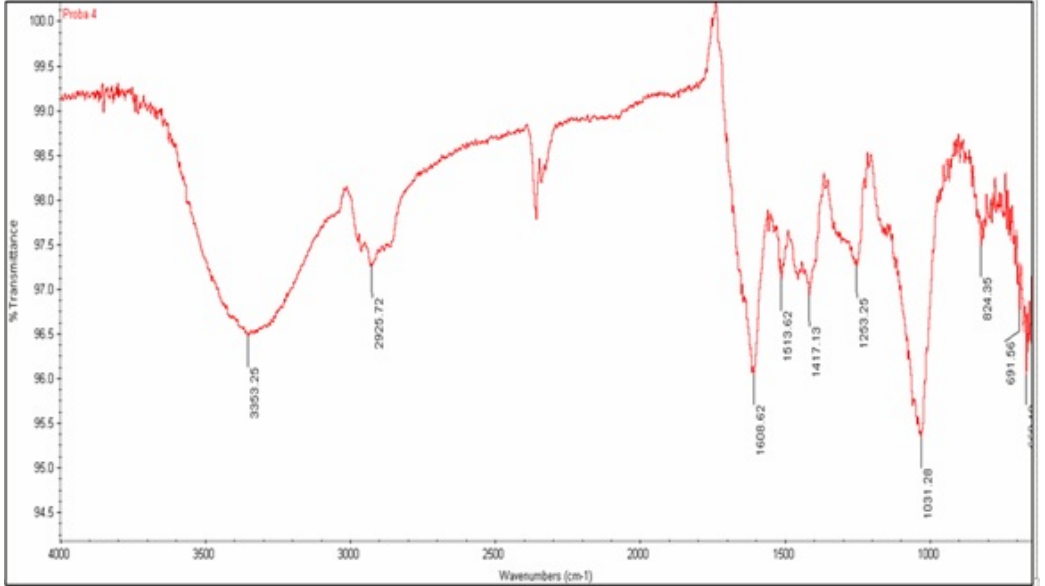
Figure 1. The FT-IR spectrum of Cystoseira barbata powder. The signal at 3353.25 cm − 1 corresponds to the -OH group ( υ OH = 3200–3600 cm − 1 ), but in the same broad band the presence of the amine group is also detected ( υ NH = 3300–3500 cm − 1 ). The width of the 3353.25 cm − 1 band denotes the association of molecules with hydrogen bonds. The presence of -NH bending at 1608.62 cm − 1 also confirms the presence of amine groups. A band of medium intensity at 2925.72 cm − 1 shows the valence vibration of C-H bonds in alkane chains ( υ CH = 2850–2960 cm − 1 ); there is a fairly broad band which may indicate the presence of a carboxylic acid with molecules strongly associated with hy- droxyl groups with hydrogen bonds ( υ - OH = 2500–3200 cm − 1 ). Some valence vibration at